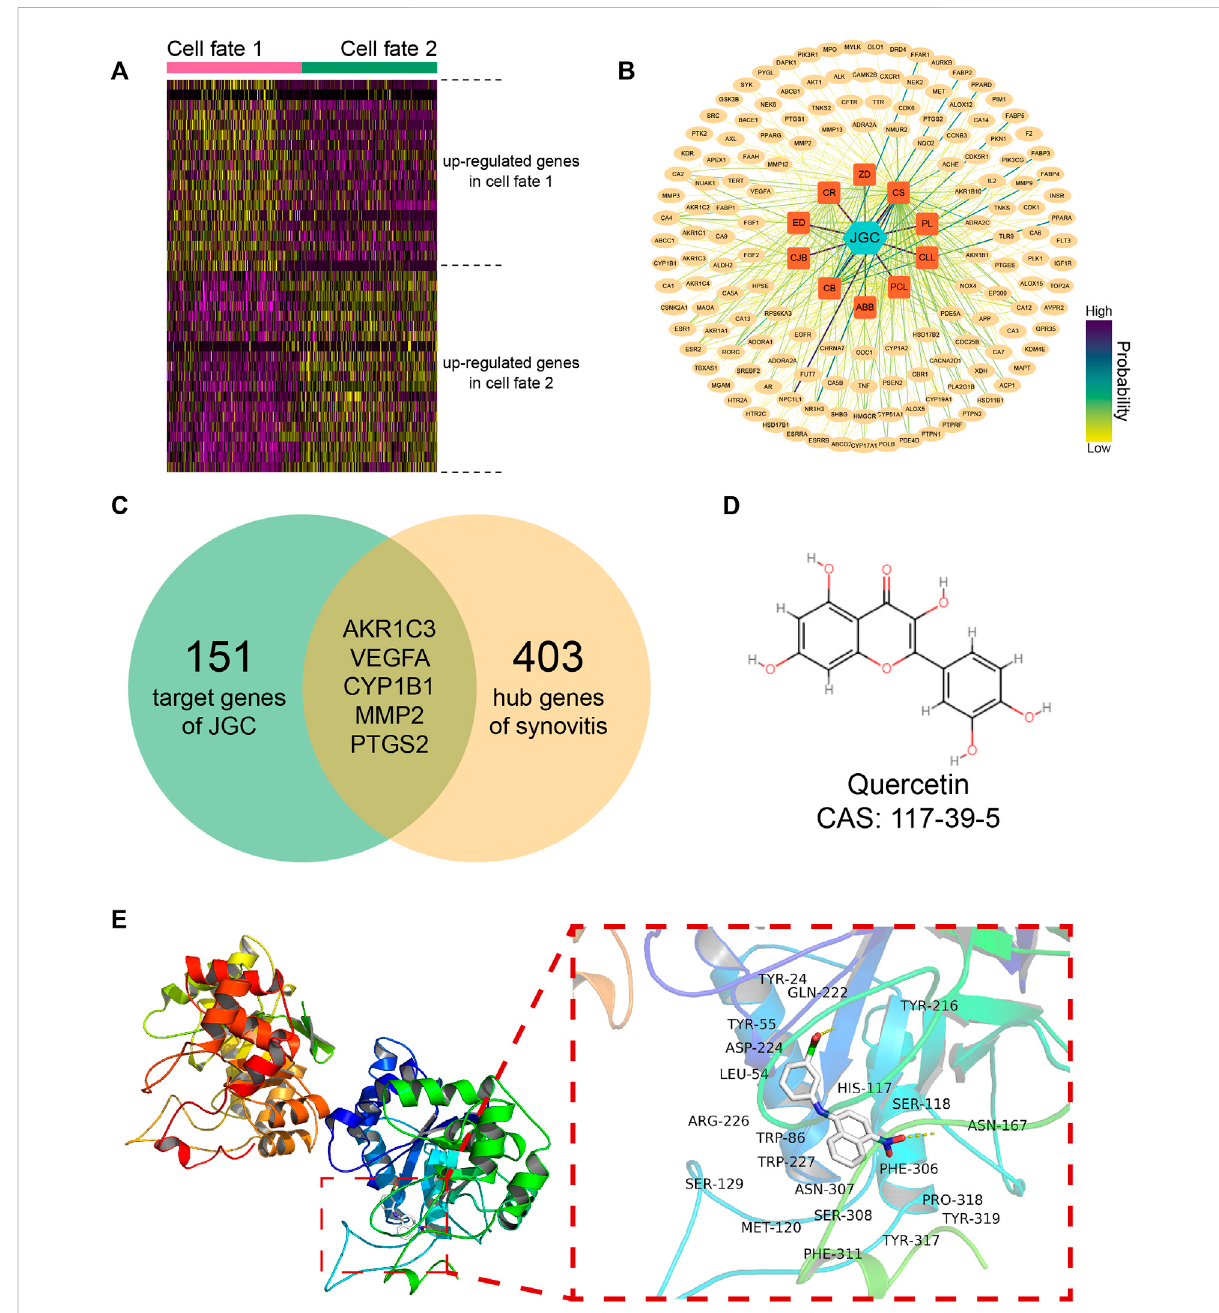
FIGURE 5 JGC treats synovitis by inhibiting AKR1C3. (A) Heatmap showing differentially expressed genes among distinct cell fates. (B) Network showing predictedtargetsofJGC. (C) VenndiagramshowingtheintersectionofJGCtargetswithhubgenesofsynovitis. (D) Molecularstructureofquercetin. (E) Molecular docking pattern of the quercetin-AKR1C3